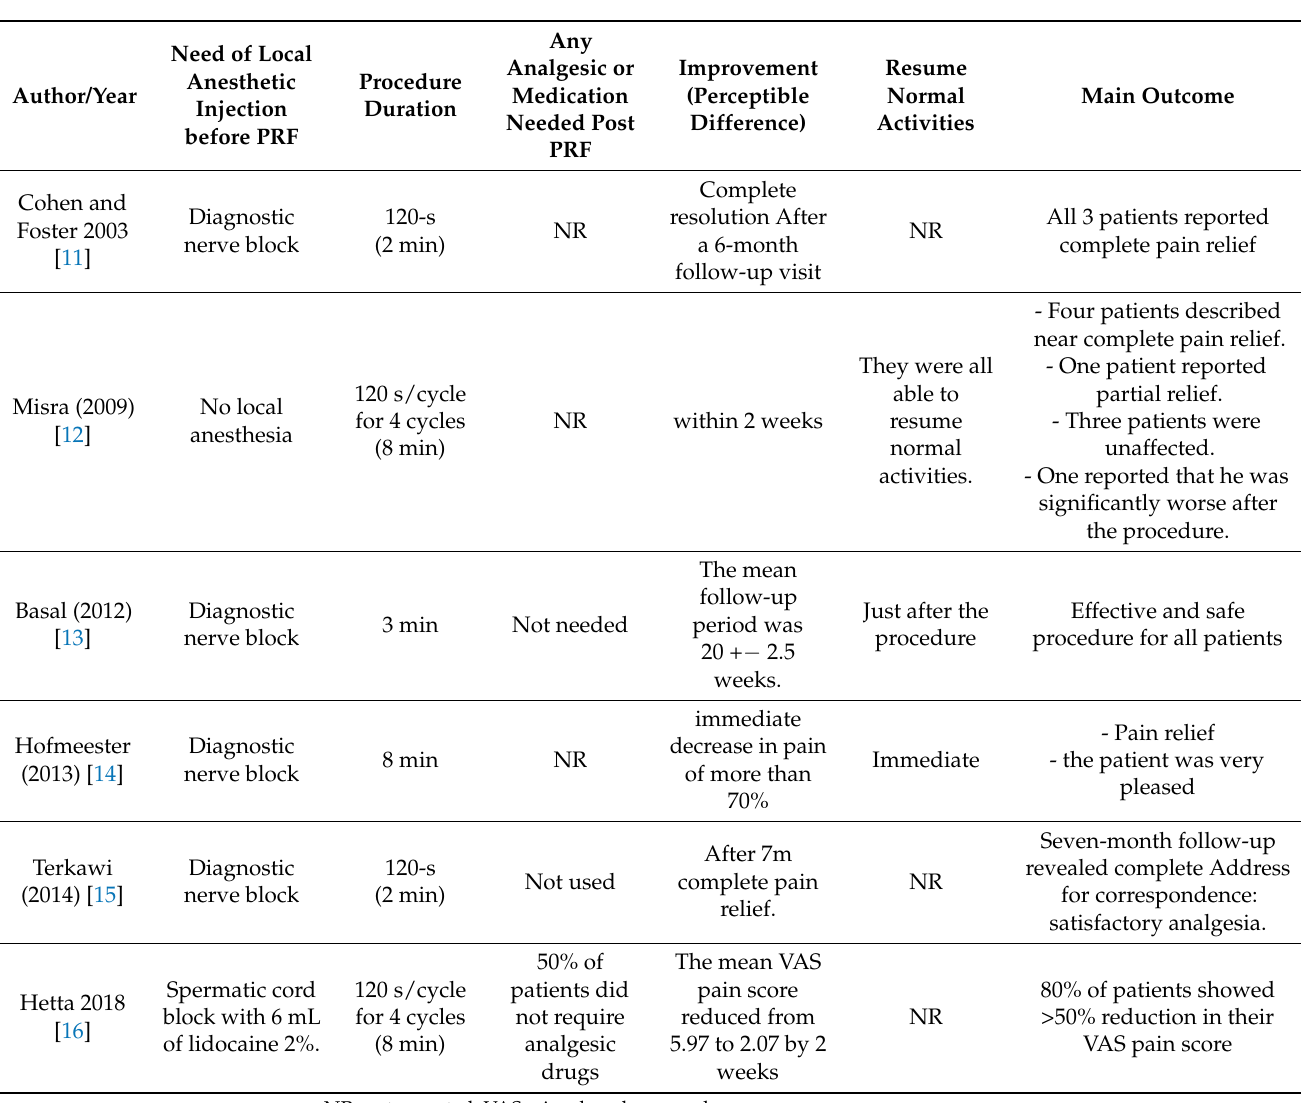
Table 4. Outcome parameters of pulsed radio-frequency therapy for orchialgia.